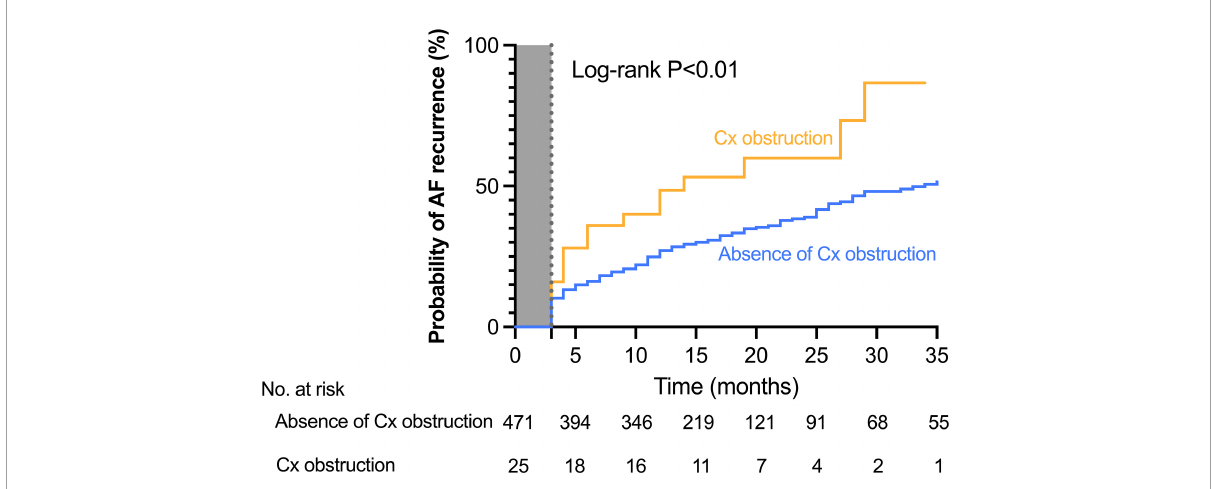
FIGURE2 Cumulative incidence of atrial fibrillation recurrence in patients with or without circumflex coronary artery obstruction. The Kaplan–Meier estimates of the AF recurrence rate after ablation stratified by the presence or the absence of circumflex obstruction. At 2 years, documented recurrence of AF had occurred in 56.0% (14 of the 25) of patients with circumflex artery obstruction and in 32.1% (151 of the 471) of patients without circumflex artery obstruction (Log-rank hazard ratio [HR], 2.06; 95% confidence interval [CI], 1.02–4.16; P < 0.01). Abbreviation: Cx, circumflex